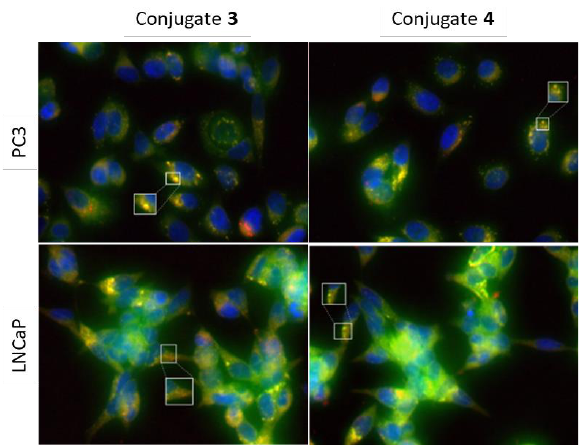
Figure 9 . Co-localization of androgen-BODIPY conjugates 3 and 4 in PC-3 and LNCaP prostate cancer cell lines after 6 h of incubation. Cells were stained with Hoechst 33258 (nucleus marker) and LAMP-2 (lysosome marker), and images were acquired with an inverted microscope at 400× magnification. Images were treated using Image J software version 1.53c (National Institutes of Health (NIH), Bethesda, MD, USA). The images are the merged results of images acquired in the different channels (Figure S10). White boxes are the amplification of intracellular regions.